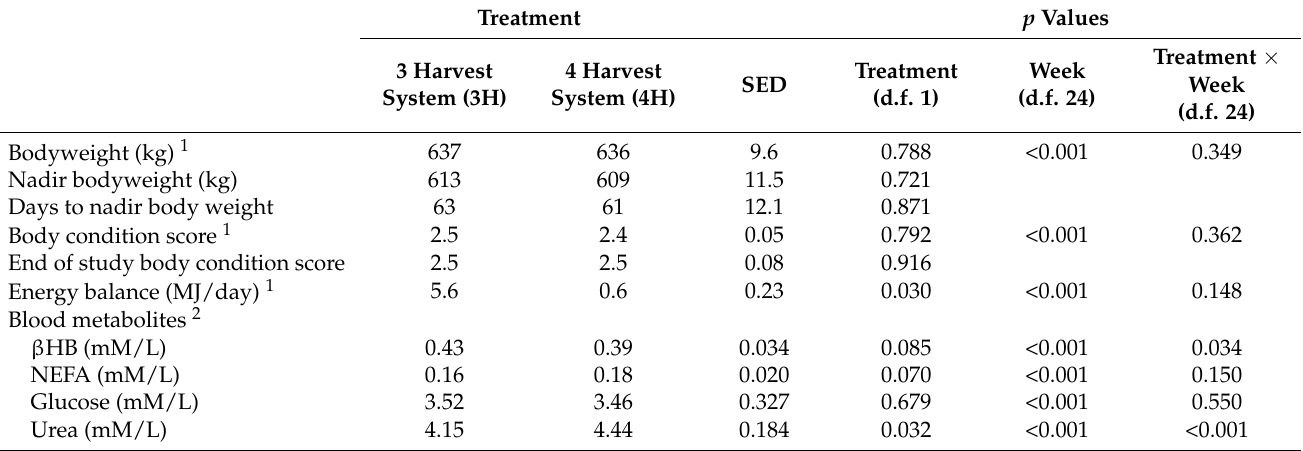
Table 4. Effect of offering silage made within either a three- (3H) or four-harvest (4H) system on cow body weight, body condition score and mean energy balance over the experimental period, and on mean blood